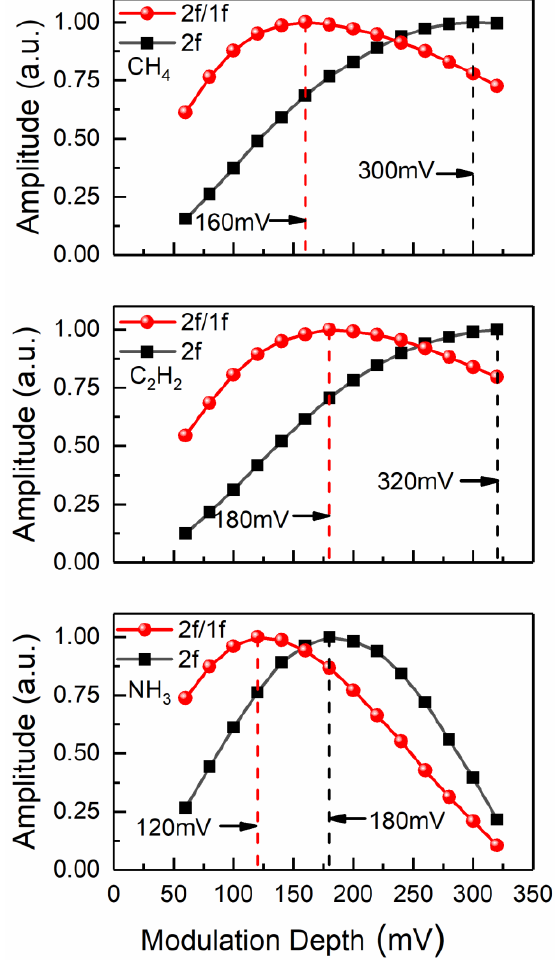
Figure 4. Normalized signal amplitude as a function of modulation depth.